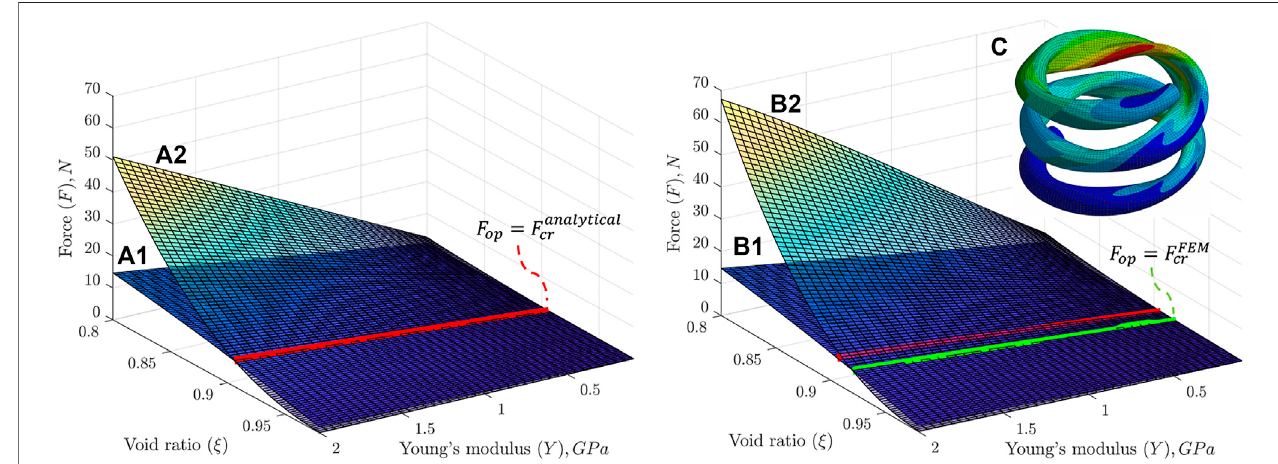
FIGURE7| Analytical (A1) operationaland (A2) criticalforcesforhollowspringswithdifferentvoidratiosandmaterialYoung ’ smoduli.Criticalstresswasconverted to critical force using Eq. 9 and compared with the operational force for a direct correlation with the numerical analysis (B1) Analytical operational and (B2) numerical buckling critical forces of the hollow spring designs. The critical force surface is interpolated from discrete values of the critical force determined numerically for several Young ’ smoduli Y (cid:1) [ 0 . 1 , 0 . 5 , 1 , 2 ] GPaandvoidratios ξ (cid:1) [ 0 . 8 , 0 . 86 , 0 . 92 , 0 . 98 ] .Inbothanalyses,theoperationalforceiscalculatedforarelativespringde fl ection of (cid:1) δ (cid:1) 0 . 4 considering the safety factor of n τ (cid:1) 2. (C) Torsional wall buckling mode of the hollow spring as observed in the numerical non-linear FEM